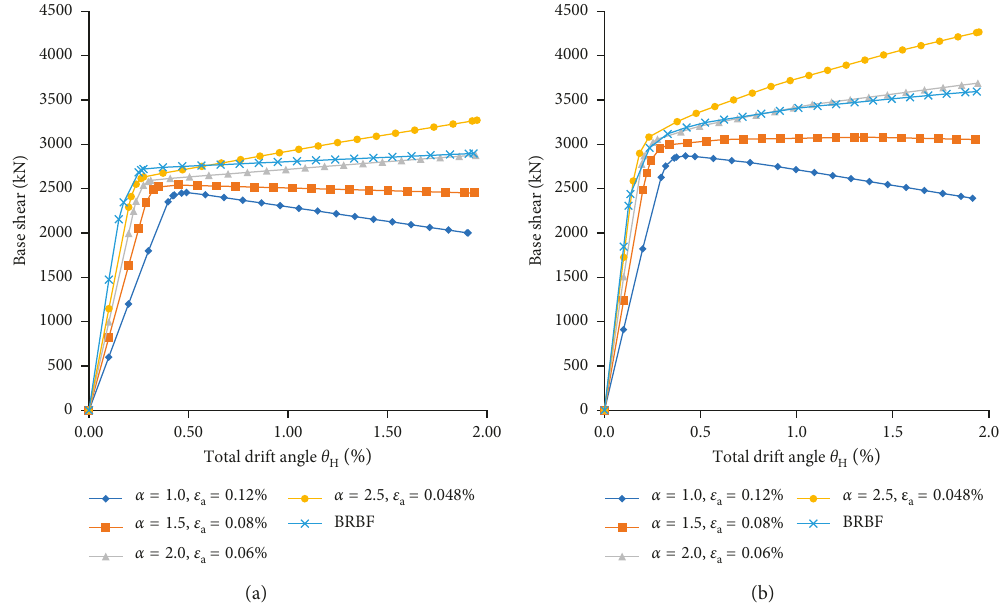
Figure 24: The effects of ε and α on the base shear response of 9-story SC-TOBFs: (a) LD-1 and (b) a